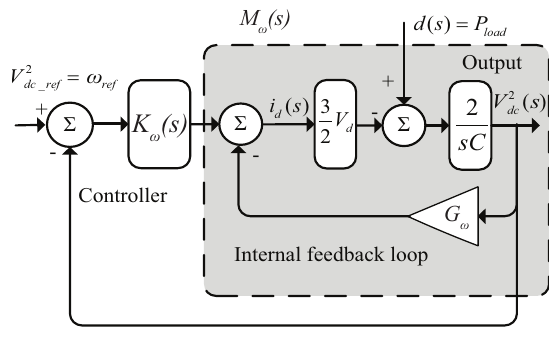
Figure 7. DC voltage control loop.